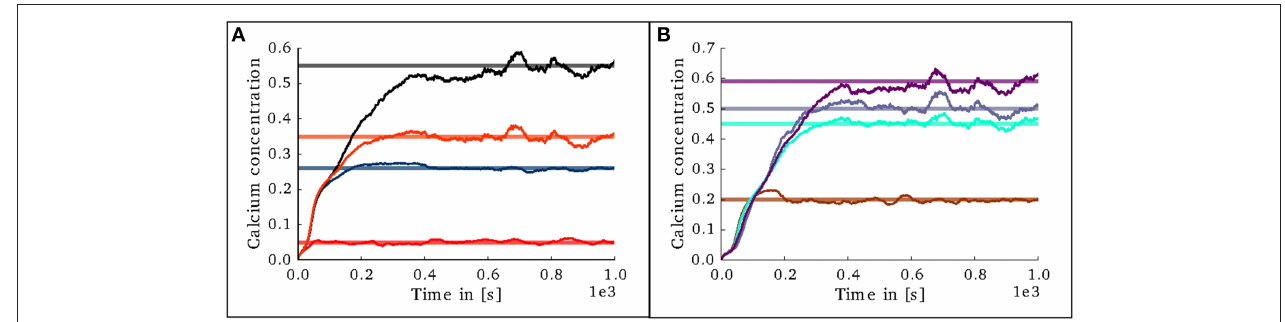
FIGURE 6 | Evolution of calcium concentration in each layer of the cortical microcircuit model. Pale horizontal lines indicate the target concentration of the corresponding population. (A) Excitatory populations in layers II/III (red), IV (blue), V (black), and VI (orange). (B) Inhibitory populations in layers II/III (brown), IV (cyan), V (gray,) and VI